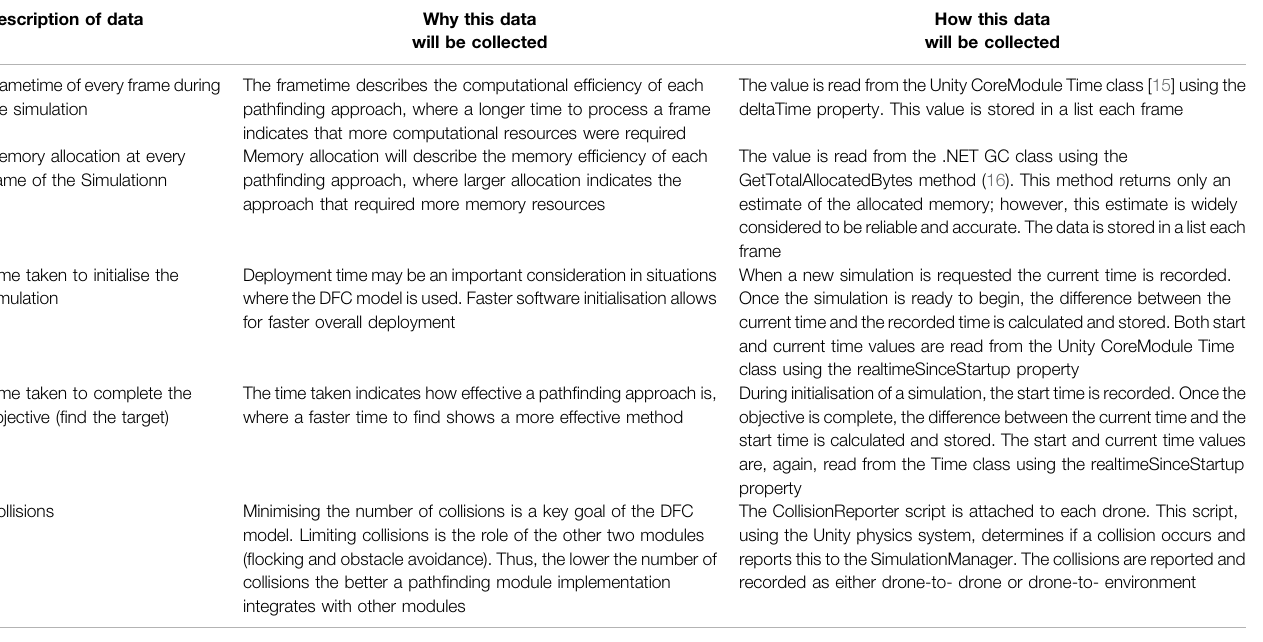
TABLE 5 | Data collection from test simulations.